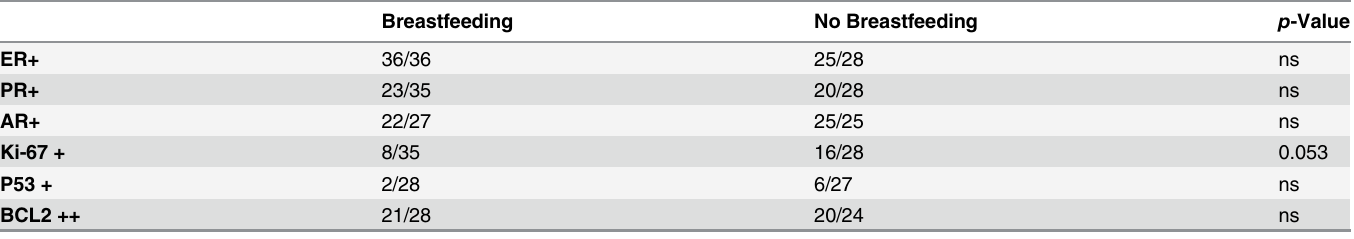
ER: estrogen receptor; PR: progesterone receptor; AR: androgen